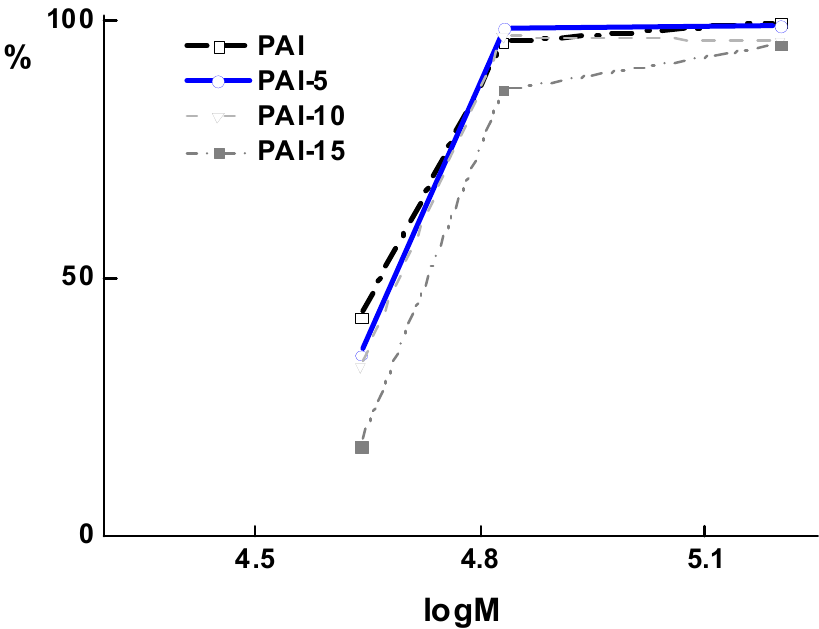
Figure 9. Dependence of proteins’ rejection on their molecular weights for PAI- c PAN membranes.